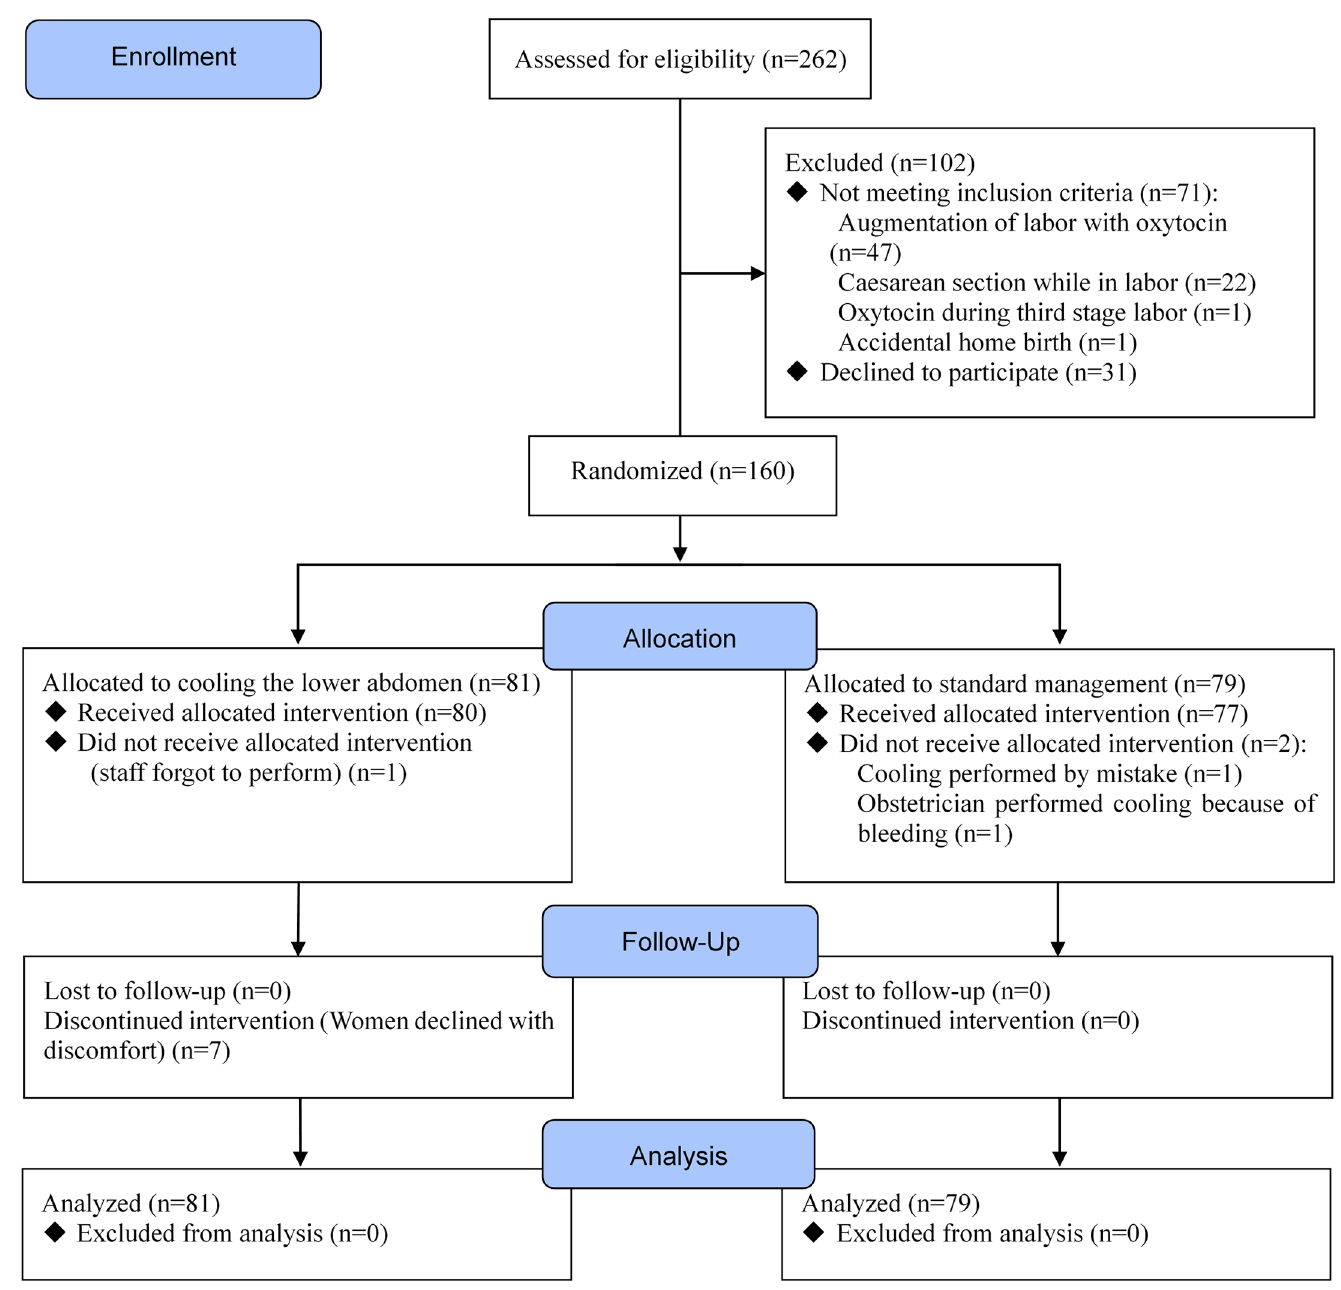
Fig 1. Trial flow diagram.